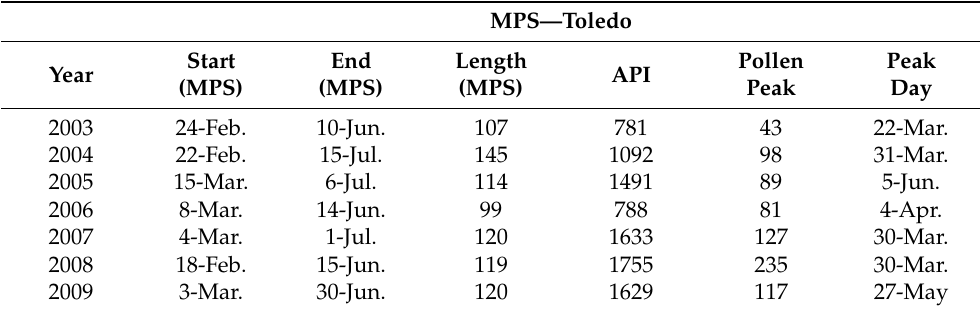
Table 3. Pinus MPS during the 25 study years in the Mediterranean area (Toledo): start date, end date, length, API (pollen grains), daily pollen peak (pollen grains/m 3 ) and peak date. Average, minimum and maximum values, standard deviation (SD) and relative standard variation in percentage (%RSD) are included. The logistic method was